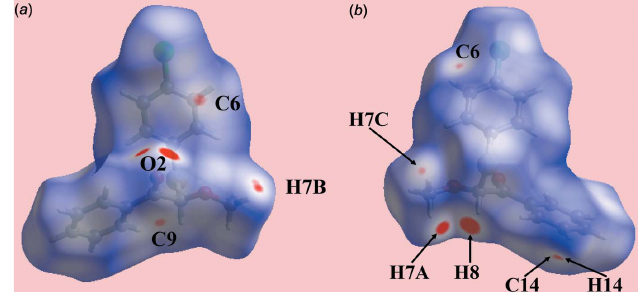
Figure 3 Two views of the Hirshfeld surface for (I) mapped over d norm in the range (cid:5) 0.073 to +1.389 au.